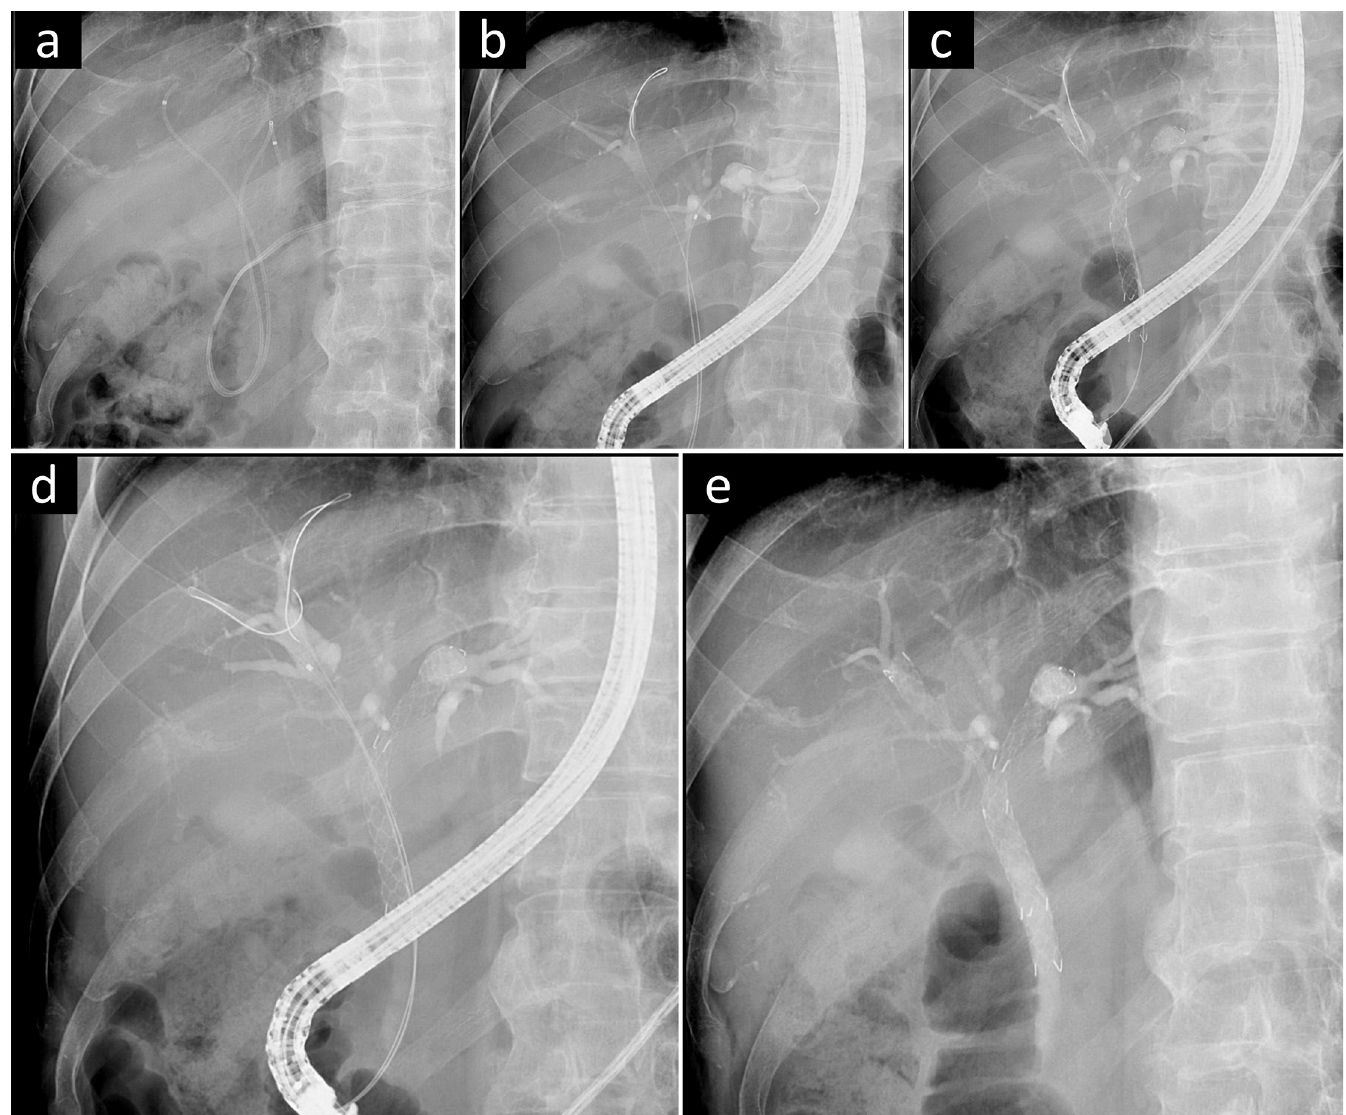
Fig 1. A case of bilateral metal stenting for malignant hilar obstruction. a. Fluoroscopic view with bilateral nasobiliary drainage; b. After biliary cannulation, two 0.025-inch guidewires were placed in the left and right hepatic duct; c. The first stent was deployed in the left duct, and the remaining guidewire was inserted through the cell of the left stent with the guidewire in the right duct as the reference; d. A catheter was introduced to confirm resistance and to evaluate the right duct again; e. The second stent was then deployed as the stent-in-stent